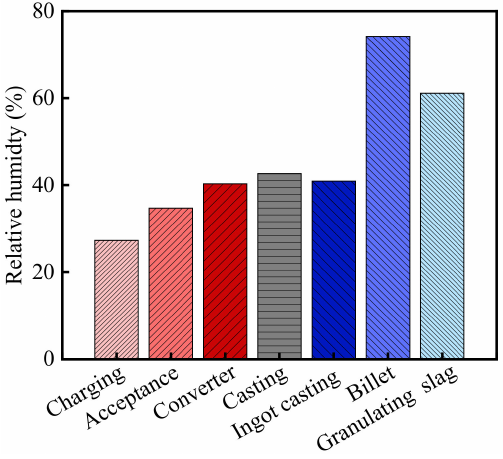
Figure 2. Relative humidity in the